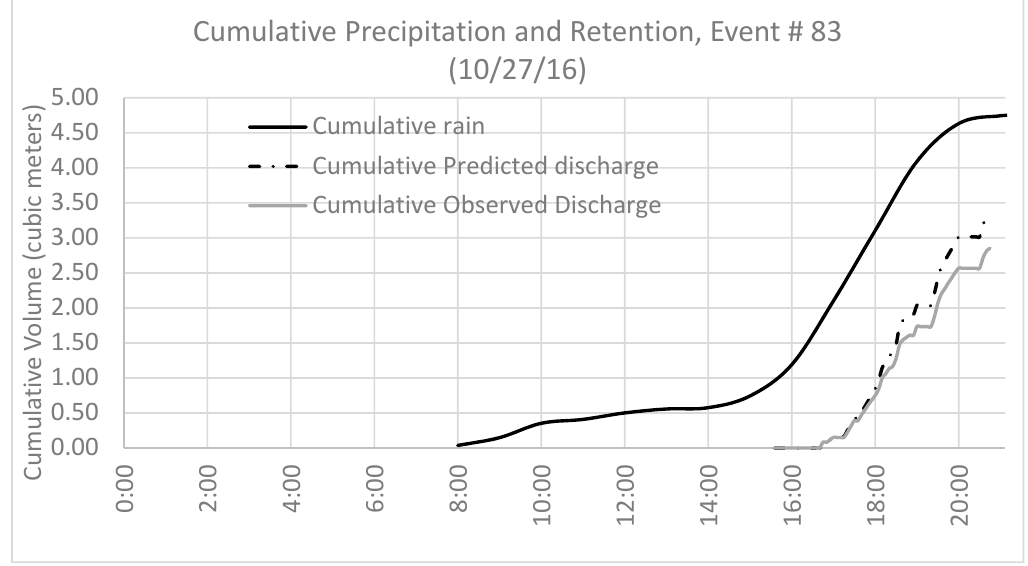
Figure 4. Runoff hydrograph of event 83 on 27 October 2016.